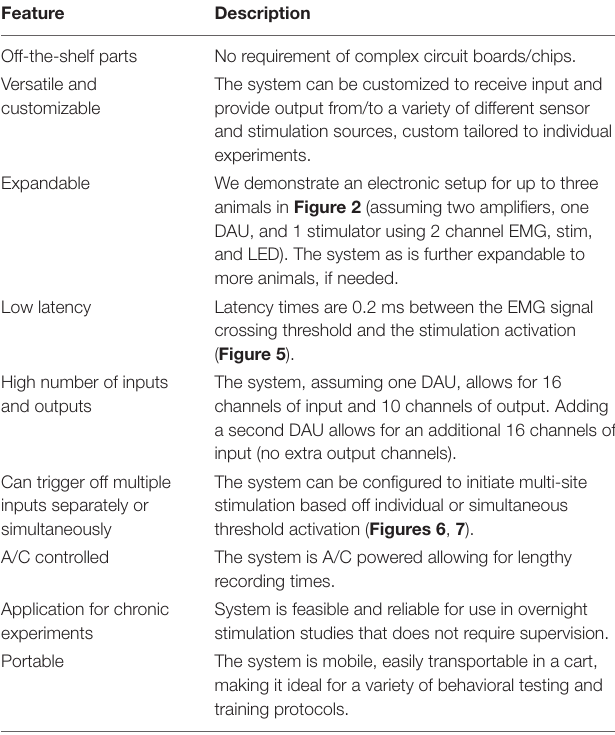
TABLE 1 | Features of the closed-loop system.